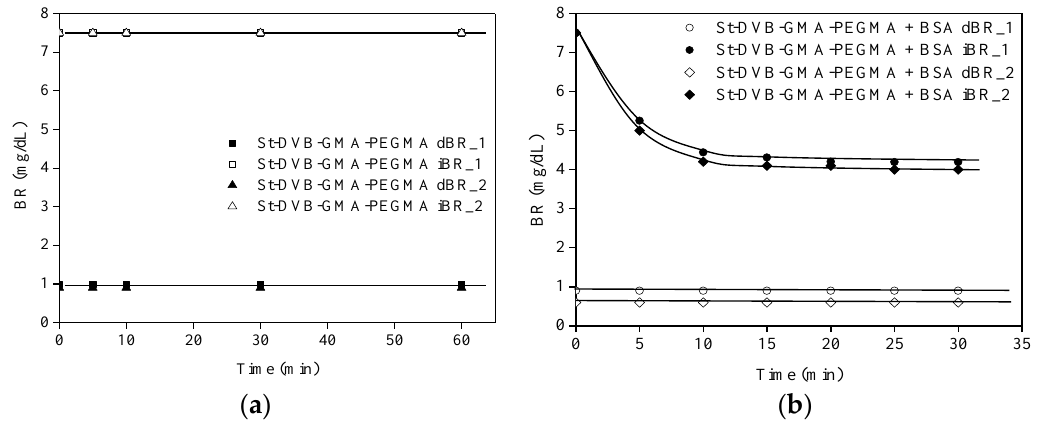
Figure 7. Kinetics of bilirubin removal from plasma by St-MMA-GMA-PEGMA particles without BSA ( a ) and with BSA ( b ) wetted with ethyl lactate. Wp = 1.2 g; T = 25 ° C and Fr= 120 mL/min.